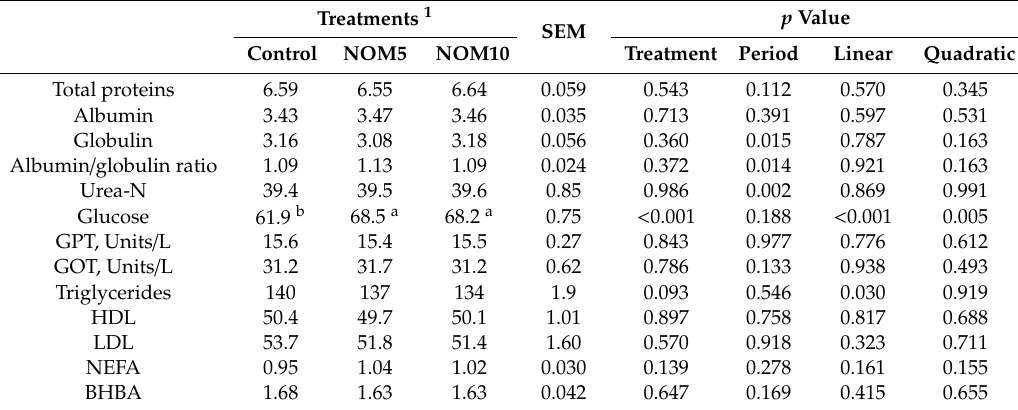
Table 6. Serum metabolites (g / dL, unless stated otherwise) of lactating Nubian goats fed a basal diet supplemented with N. oculata